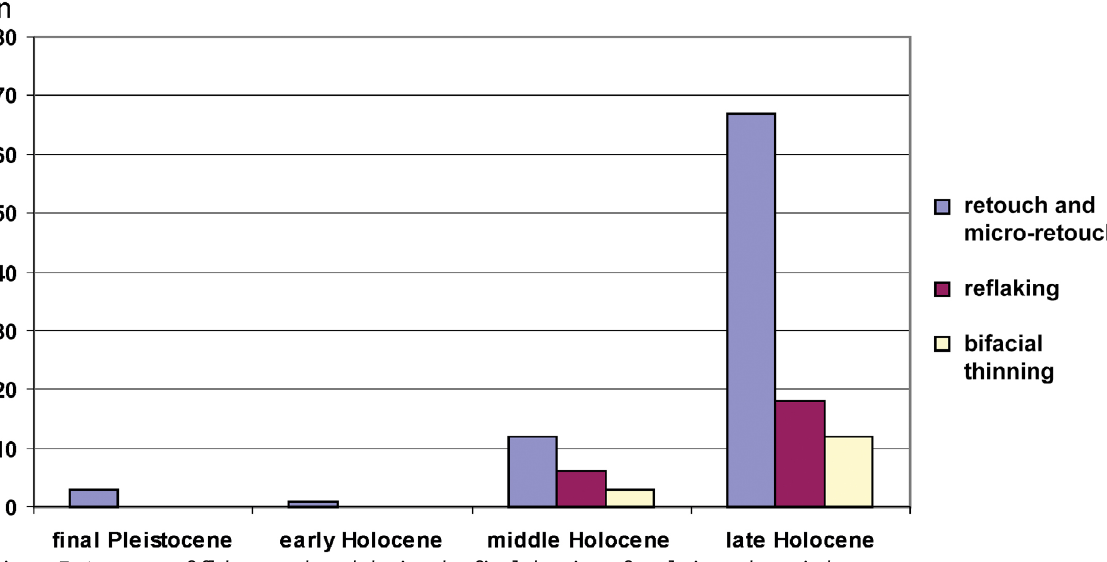
Figure 7. Amount of flakes produced during the final shaping of tools in each